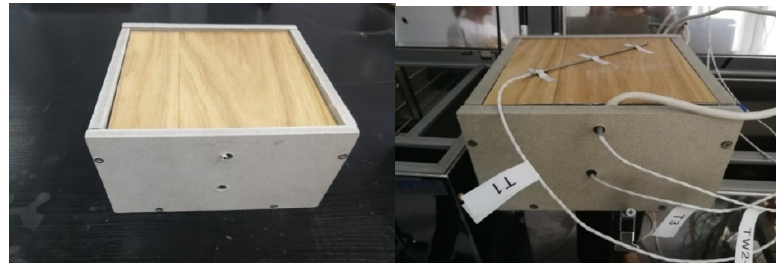
Figure 2. The housing of a heated floor sample type D (dry rooms).